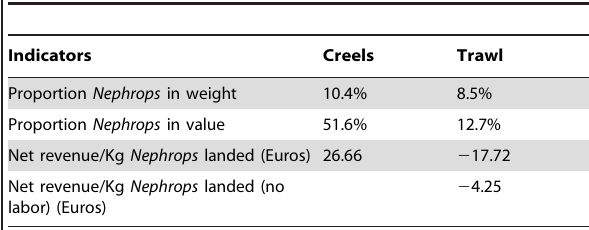
Table 6. Importance of Nephrops in the fishery and efficiency of the gears.